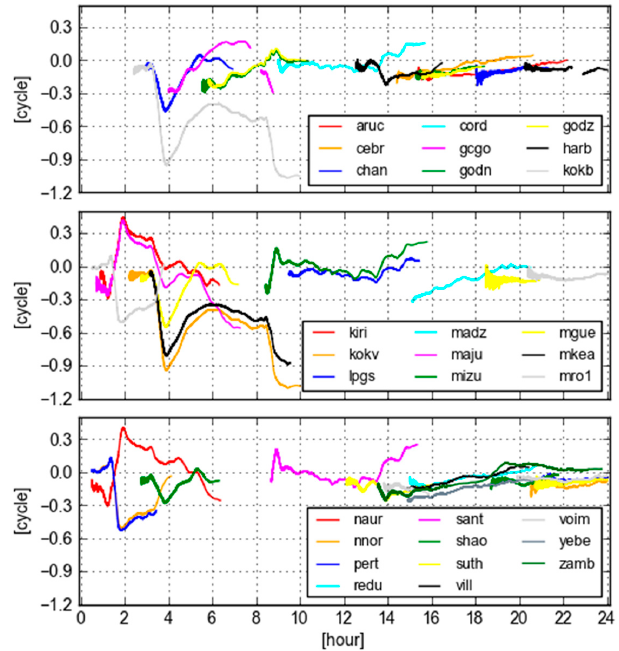
Figure 9. GB-GF WL ambiguities computed with real-time orbit clock products for GPS PRN 09 at all selected sites.